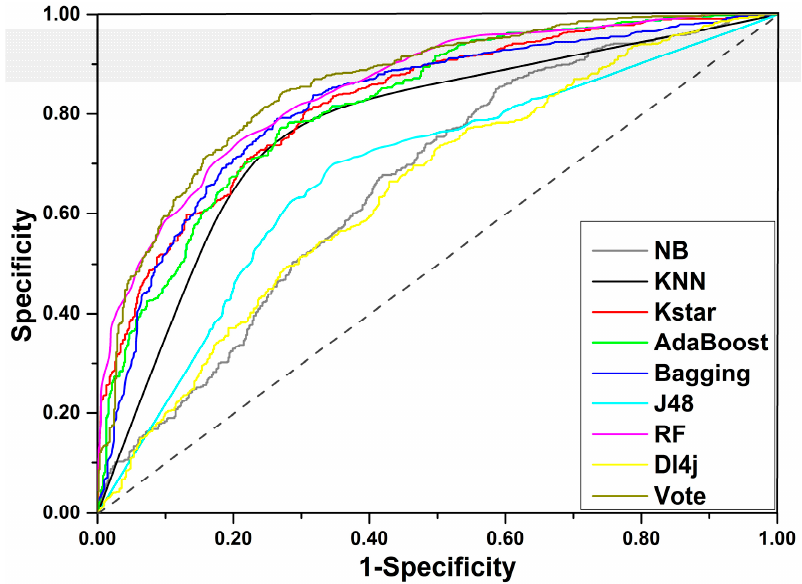
Figure 3. ROC curves for the training set.